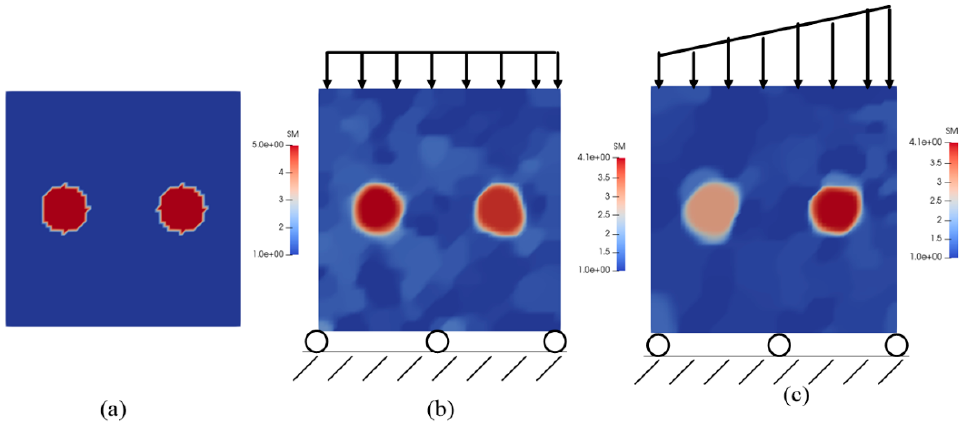
Figure 1. ( a ) Target shear modulus distribution. ( b ) Reconstructed shear modulus distribution when the loading is uniform. ( c ) Reconstructed shear modulus distribution when the loading is non-uniform.